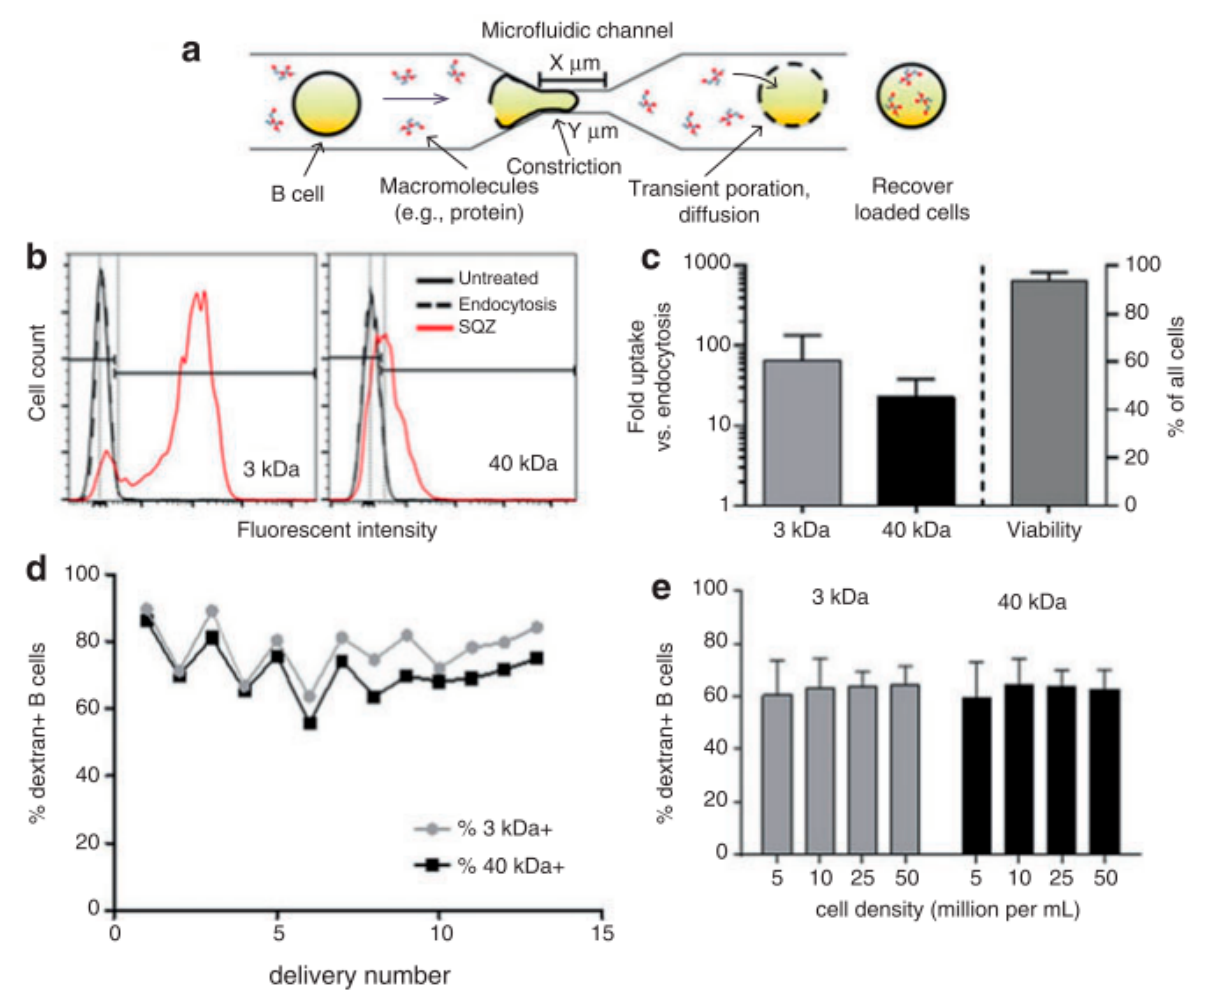
Figure 5. ( a ) Schematic of the cells moving through a micro constriction in the platform. ( b ) Fluorescence intensity comparison between control cells and cells used in the cell squeeze device for transfection of 3-kDa and 40-kDa dextran. ( c ) Cargo uptake study with respect to the number of folds of delivery via endocytosis for 3-kDa and 40-kDa dextran ( d ) Comparison of transfection efficacy for 3-kDa and 40-kDa dextrans. ( e ) Transfection efficacies of 3-kDa and 40-kDa dextrans for various cell densities. Reprinted with permission from ref. [83]. Copyright © 2015 Gregory Lee Szeto et al.